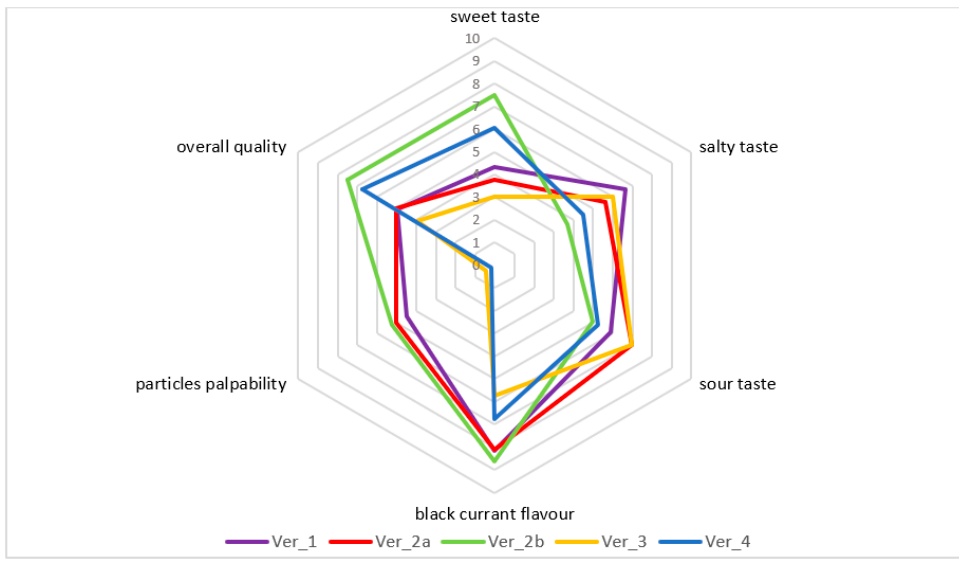
Figure 5. The sensory qualities of the designed recovery beverages.